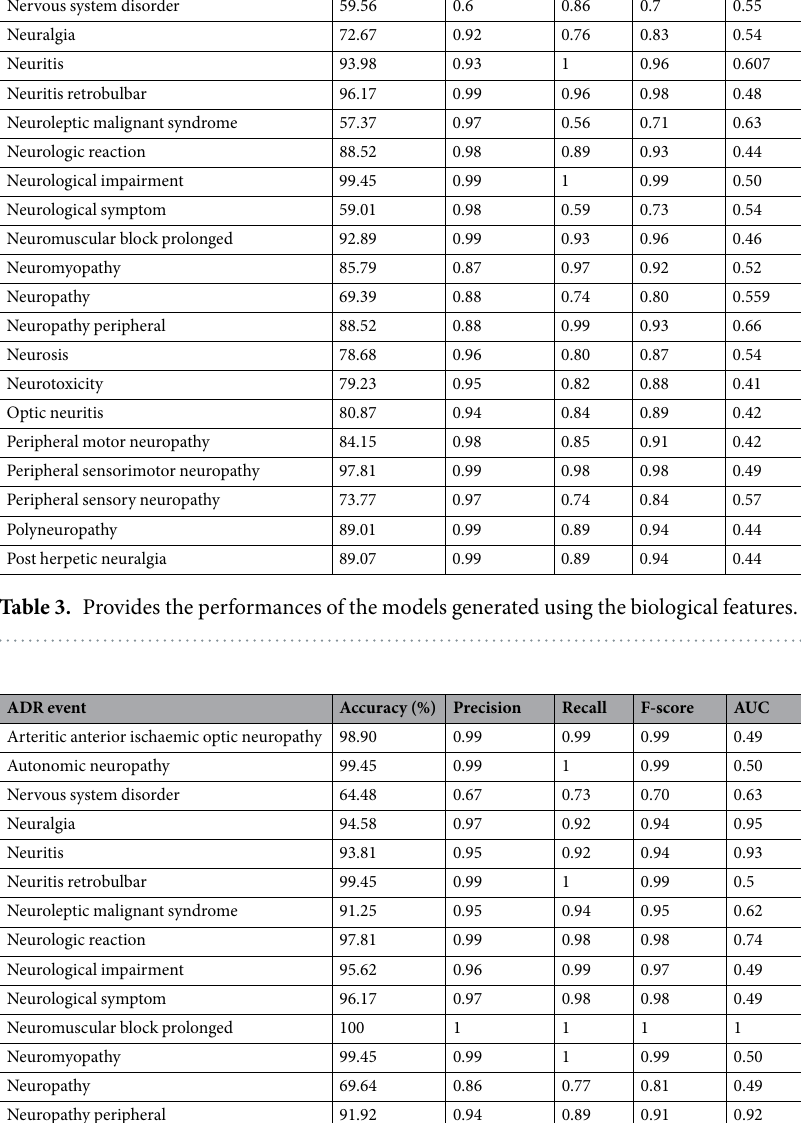
(Table 7). The combined biological + chemical models were least accurate among all three sets with accuracy 91.47%, precision, recall and F-score values equalling to 0.95%, 0.93% and 0.94%, respectively (Table 8). Modelling using the combined biological, chemical and phenotypic properties. The three levels of the features, biological (78), chemical (319) and phenotypic (291) were combined and a dataset of total 678 properties was created. The learned model systems generated had an accuracy value 94.18%, precision and recall